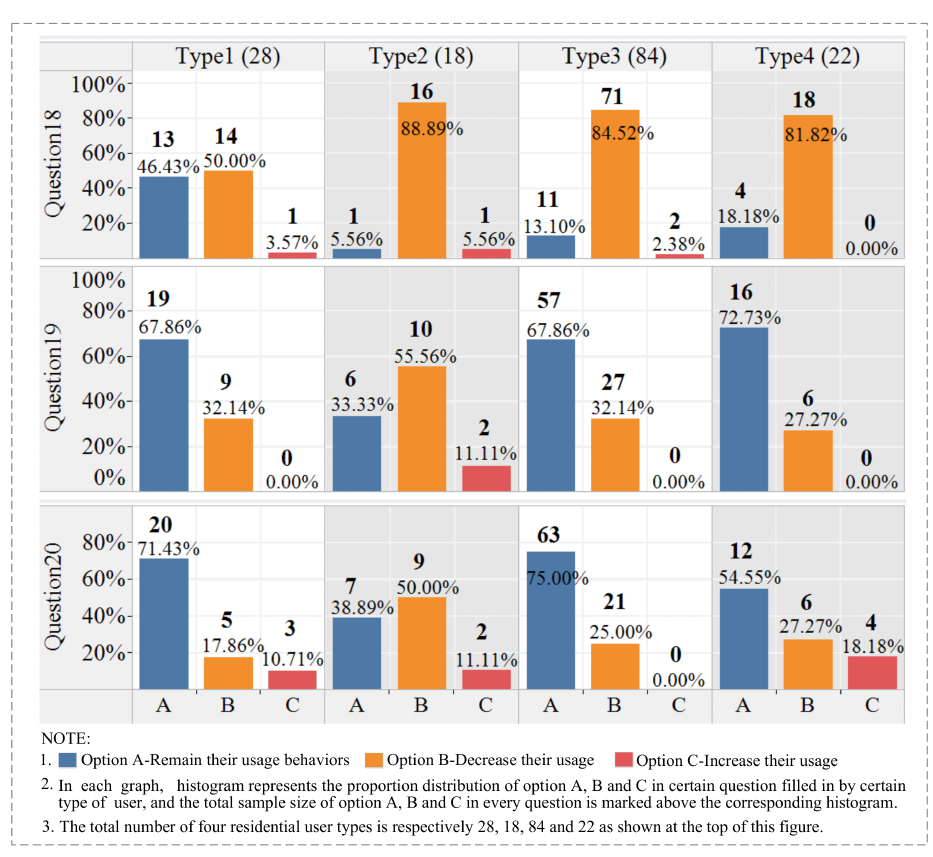
Figure 3. Proportion distribution and sample size of option A, B, C in question 18–20 filled in by four residential user